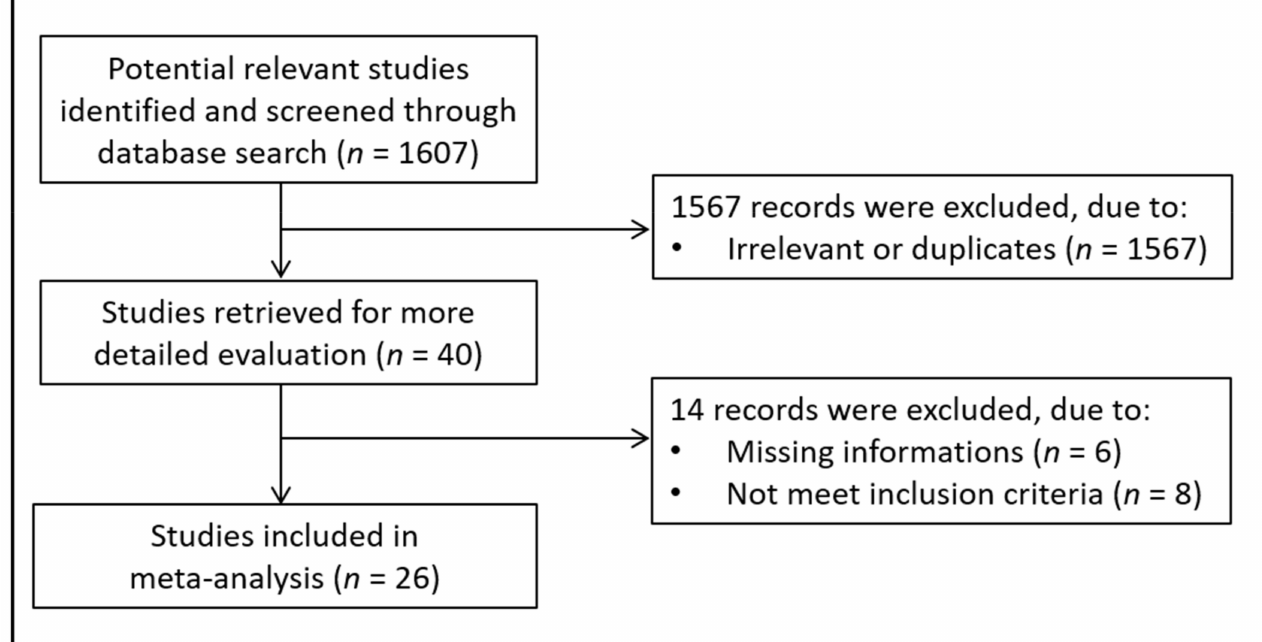
Figure 1. Flow chart of study